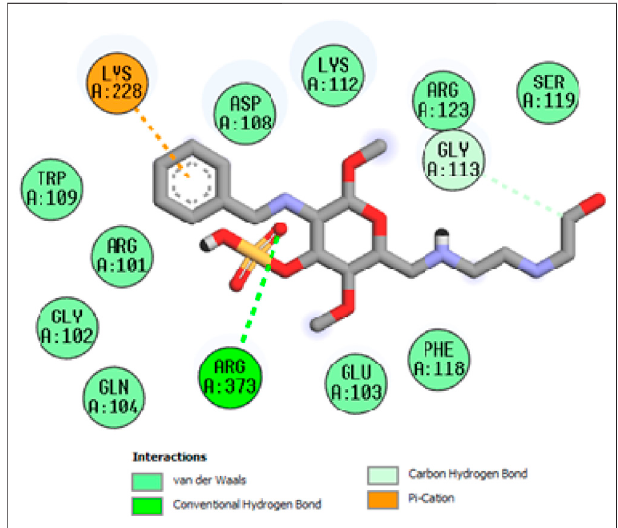
FIGURE 5 | Interaction of compound 2a in the binding pocket of 1Z11 receptor.